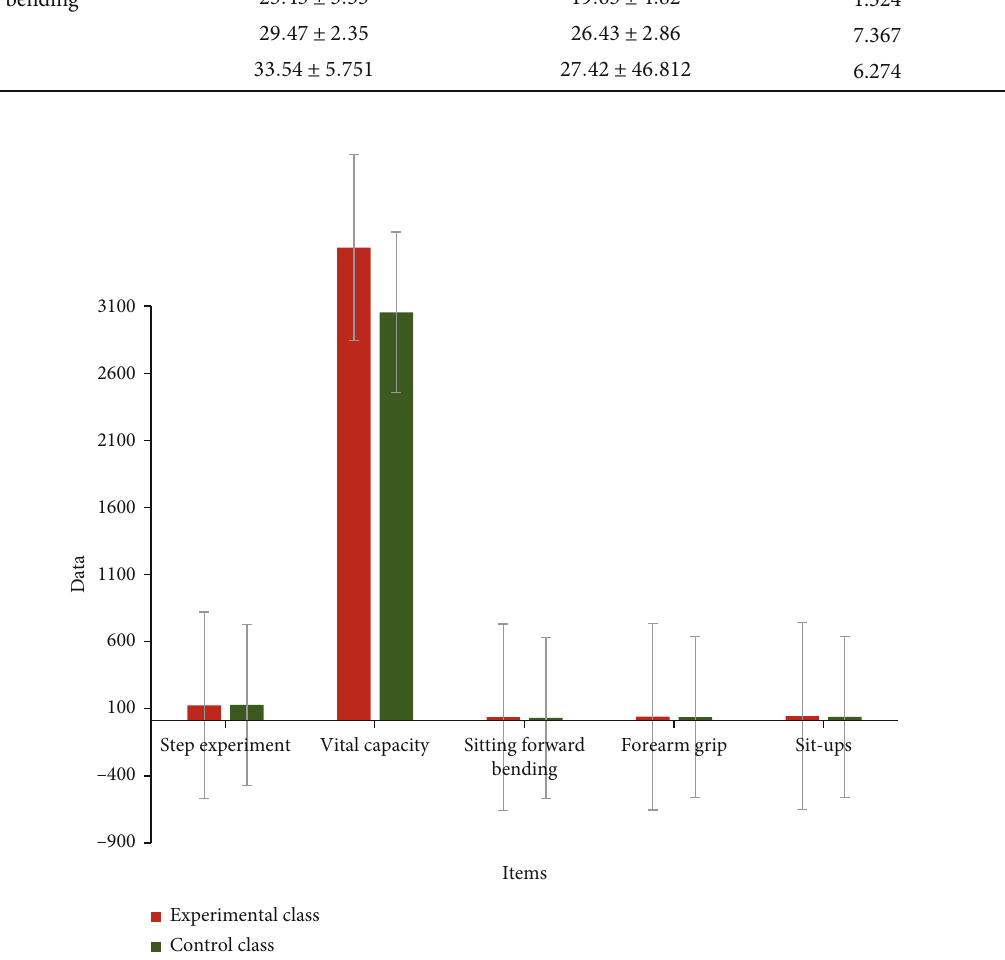
Figure 2: Comparative analysis of test results of students ’ health and physical fi tness index after experiment. Table 3: Comparison of the results of aerobics skills test between the experimental class and the control class.